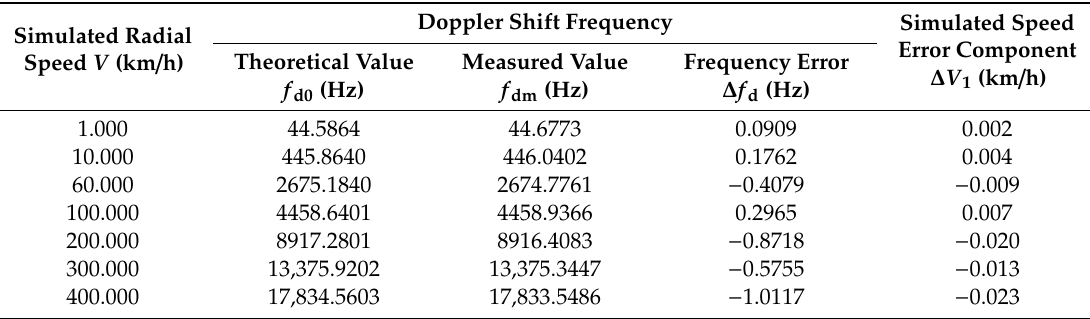
Table 3. Doppler shift frequency error and simulated speed error component in the accuracy aspect of the second moving target simulator at emitted frequency of 24,060